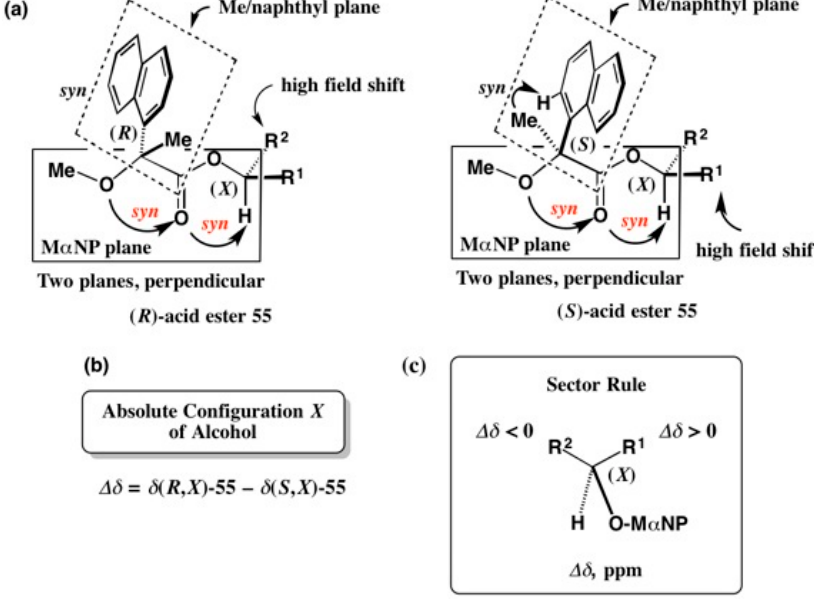
Figure 36. AC determination and mechanism of the 1H-NMR diamagnetic anisotropy method using ( R )- and ( S )-M α NP acids. ( a ) Preferred conformation of M α NP esters. ( b ) Definition of Δδ . ( c ) Sector rule for determining the absolute configuration. Redrawn with permission from [55].